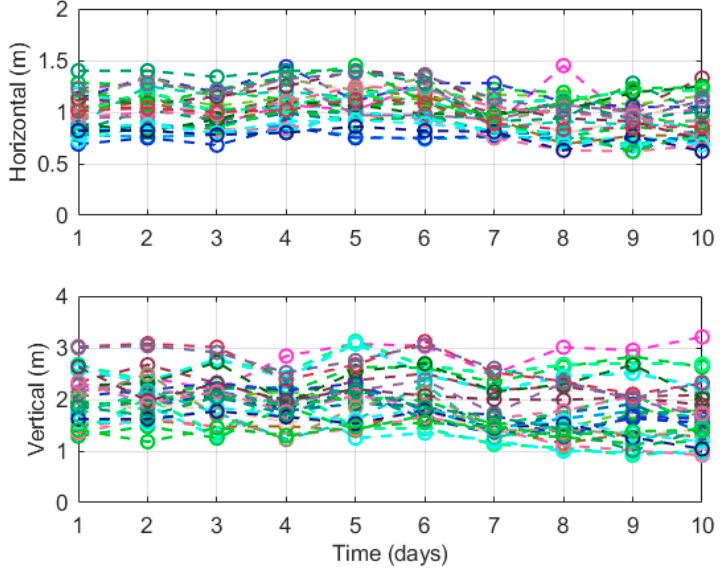
Figure 3. Time series of 95th percentile position errors for 30 monitoring receivers under BDSBAS SF service. One color represents one receiver.